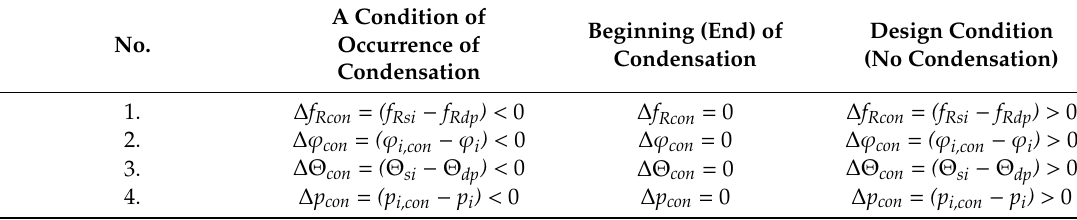
Table 4. Conditions for the occurrence of surface condensation on a building barrier in the form of a di ff erence of parameters ( ∆ ).